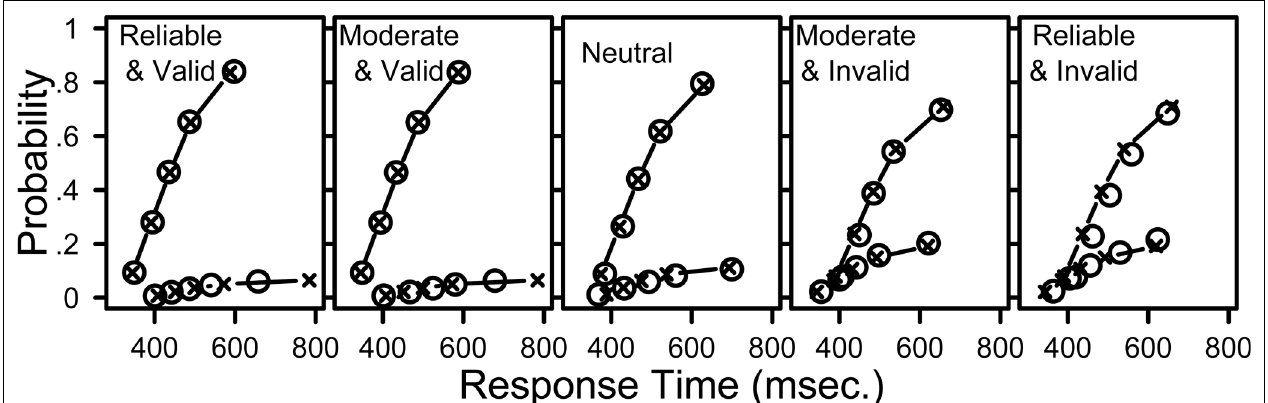
“R9” and “L9”, 70% for “R7” and “L7”, and 50% for “N5”). Valid cues predicted the direction of movement correctly and invalid cues did not. Within each panel, the upper set of lines and symbols show quantiles for correct responses, and the lower set shows quantiles for incorrect responses. The data and model predictions were averaged across participants and across leftward and rightward stimulus